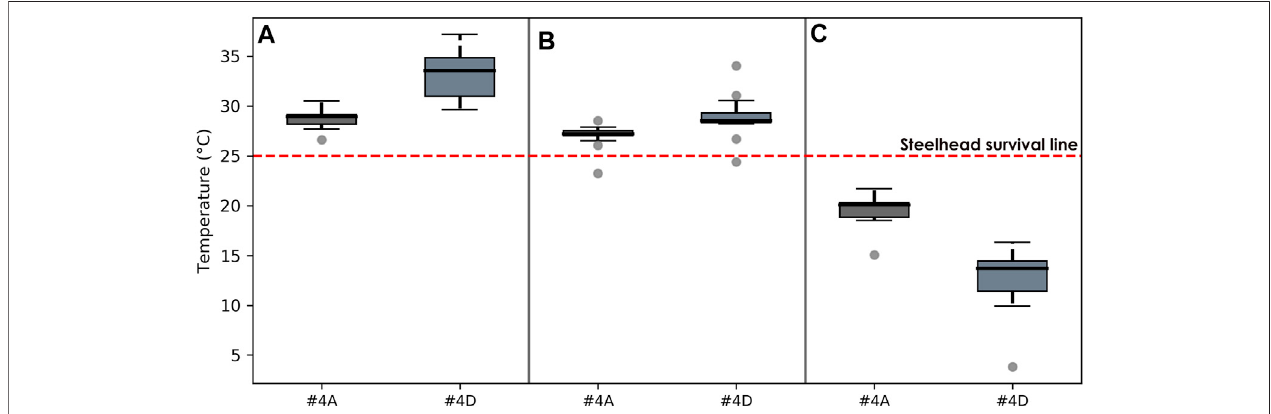
FIGURE 2 | Boxplots show the variation of the calculated thermal metrics: MaxWMT (A) , MaxWAT (B) , and MinWMT (C) for the predicted water temperatures during the migration season in 2016 (February 1 – May 31, 2016) for the upstream at station #4A and downstream at station #4D. The red dashed line shows the maximum temperature a steelhead could tolerate.